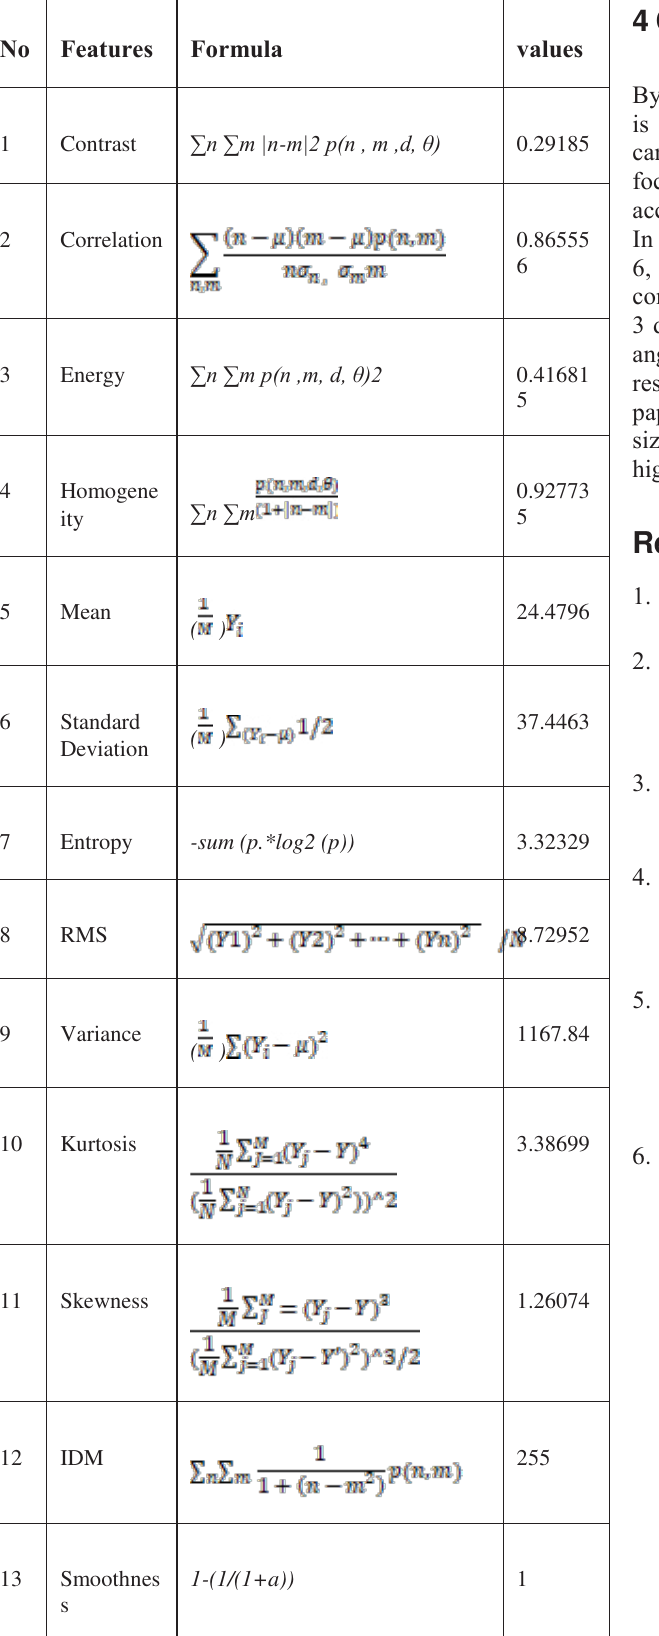
Table 1: Features Extraction Formulas and their values from Cluster size 3 of cluster 2 for co-occurrence